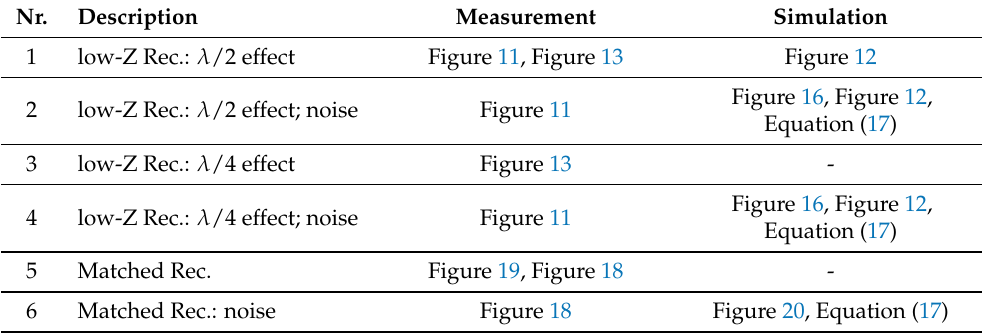
Table 1. Summary of key observations and comparison between measurements and simulations.